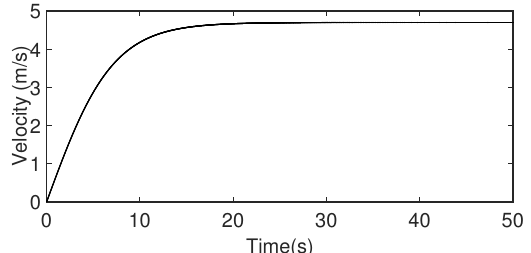
Figure 1. Kayak velocity versus time, m = 90 kg, f = 60 N, d = 2.72 kg/m.